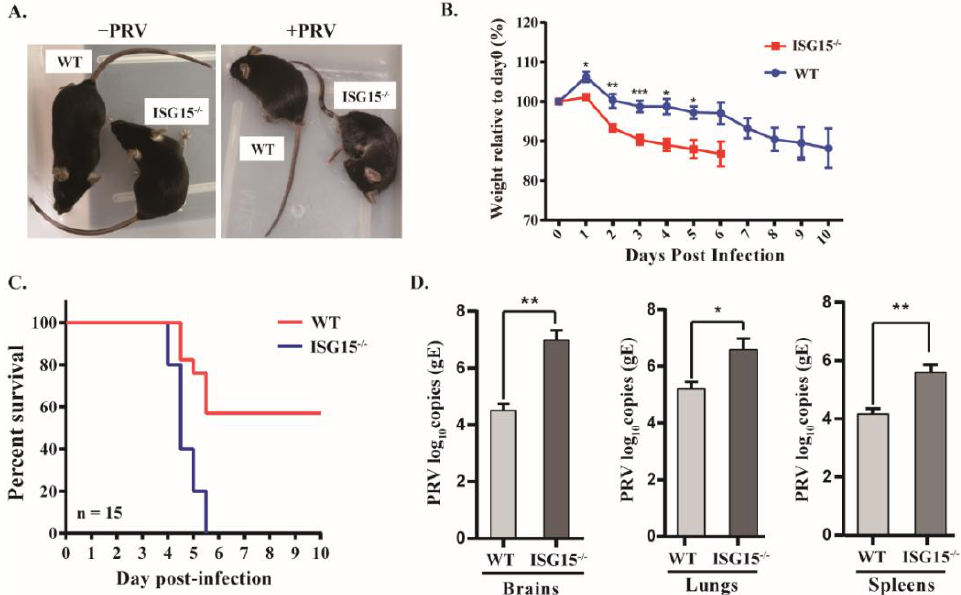
Figure 1. Mice lacking ISG15 are more susceptible to PRV than WT mice. ( A ) The clinical aspects of WT and ISG15-deficient (ISG15 -/- ) mice infected intraperitoneally with PRV are shown. ( B , C ) Body weight ( B ) and survival ( C ) were monitored for 10 dpi (WT: n = 15; ISG15 -/- : n = 15). Data are shown as percent change of body weight relative to the starting weight on day 0 (mean ± SEM). Survival curves were compared using a log-rank test. ( D ) At 4 dpi, the brain, lung and spleen tissues of the infected mice were harvested and homogenized, and PRV gE gene copies were assayed by quantitative real-time PCR (RT-qPCR). PRV-infected ISG15 -/- mice vs. PRV-infected WT mice. * p < 0.05; ** p < 0.01; *** p < 0.001.